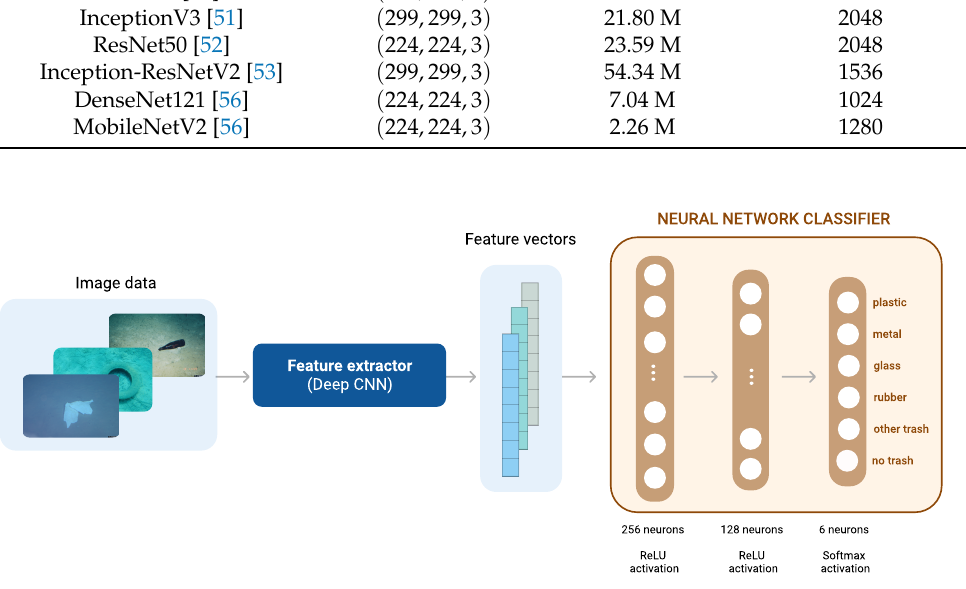
Figure 16. Classification of marine debris images using a neural network classifier, which receives extracted feature vectors as inputs and outputs class-wise probability distribution.